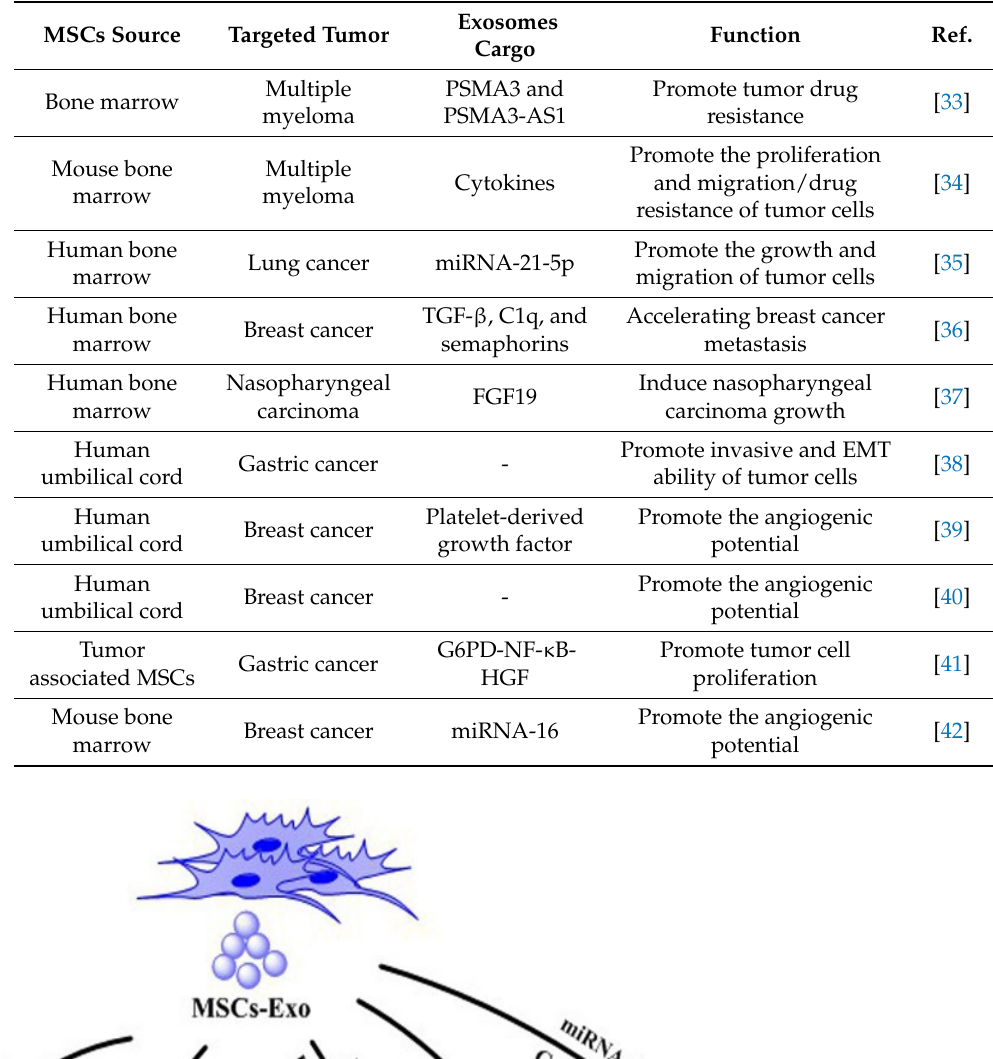
Table 2. Promoting function of MSCs-Exo.